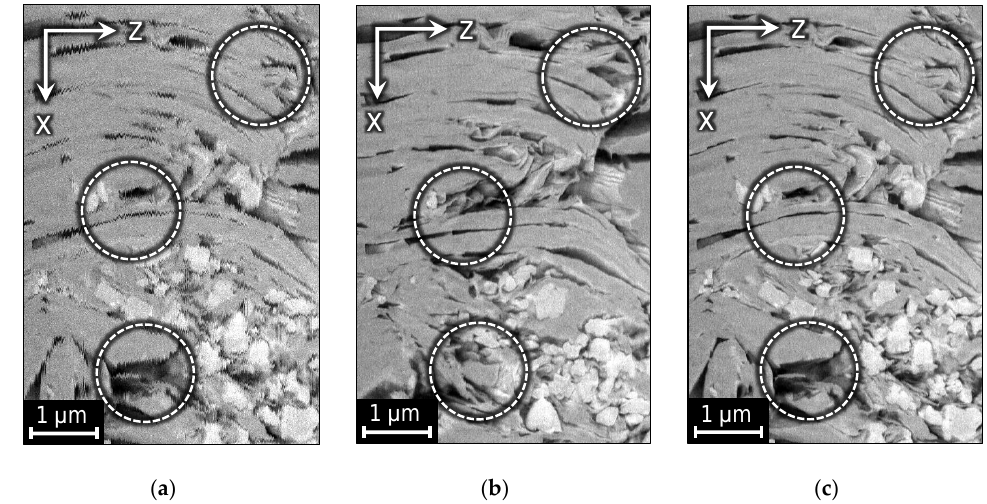
Figure 2. Distortions in the sample structure after alignment of slices and results of the proposed algorithm: ( a ) side view of the original 3D image; ( b ) side view of the image after conventional alignment; ( c ) side view of the image after the proposed alignment procedure.